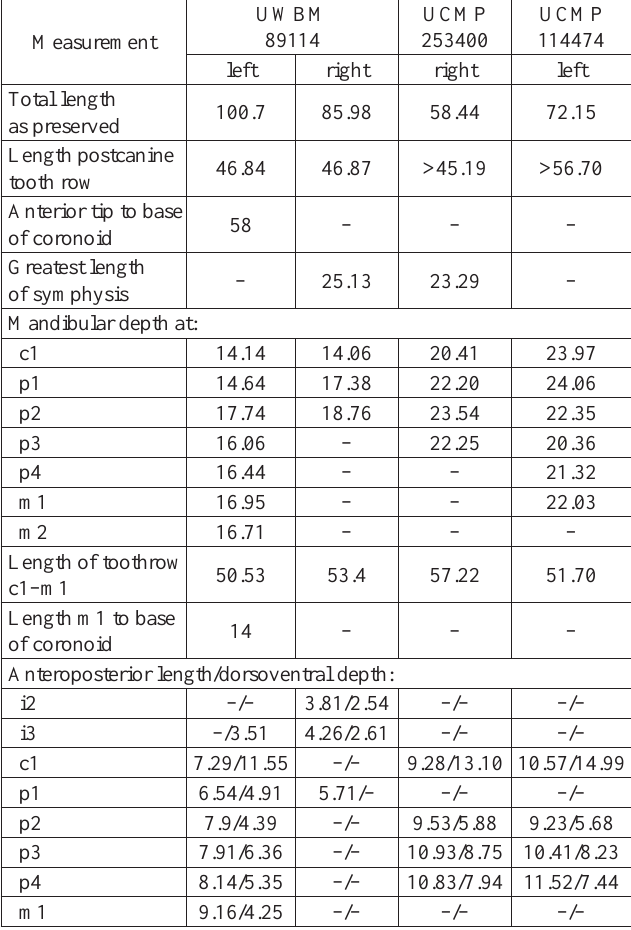
Table 1. Measurements (in mm) of Enaliarctos sp.